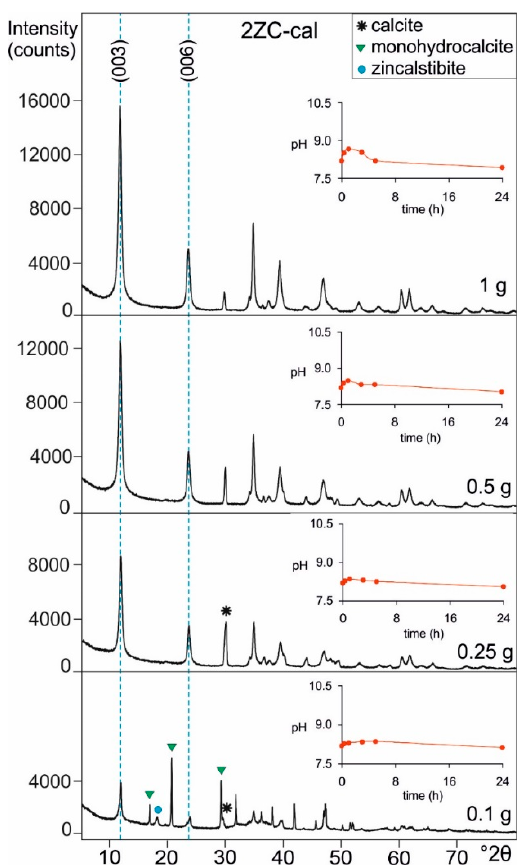
Figure 6. XRD patterns of 2ZC-cal recovered after the sorption experiments with the slag drainage SU1 performed with different amounts of 2ZC-cal (0.1, 0.25, 0.5, 1 g). On the upper right side of each XRD pattern the pH of solution as a function of time during each experiment is reported. The blue dashed lines indicate the basal reflection of LDHs formed after the sorption experiments.